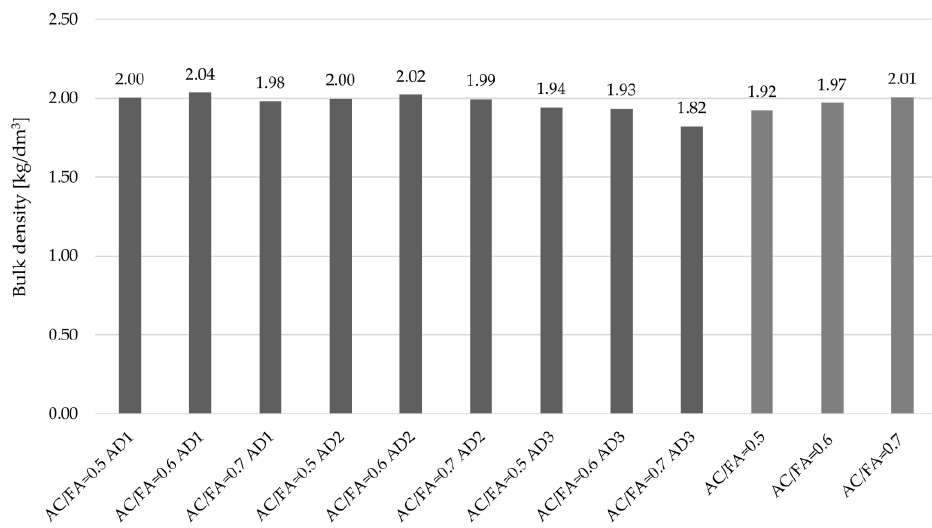
Figure 7. Bulk density results for all the series.